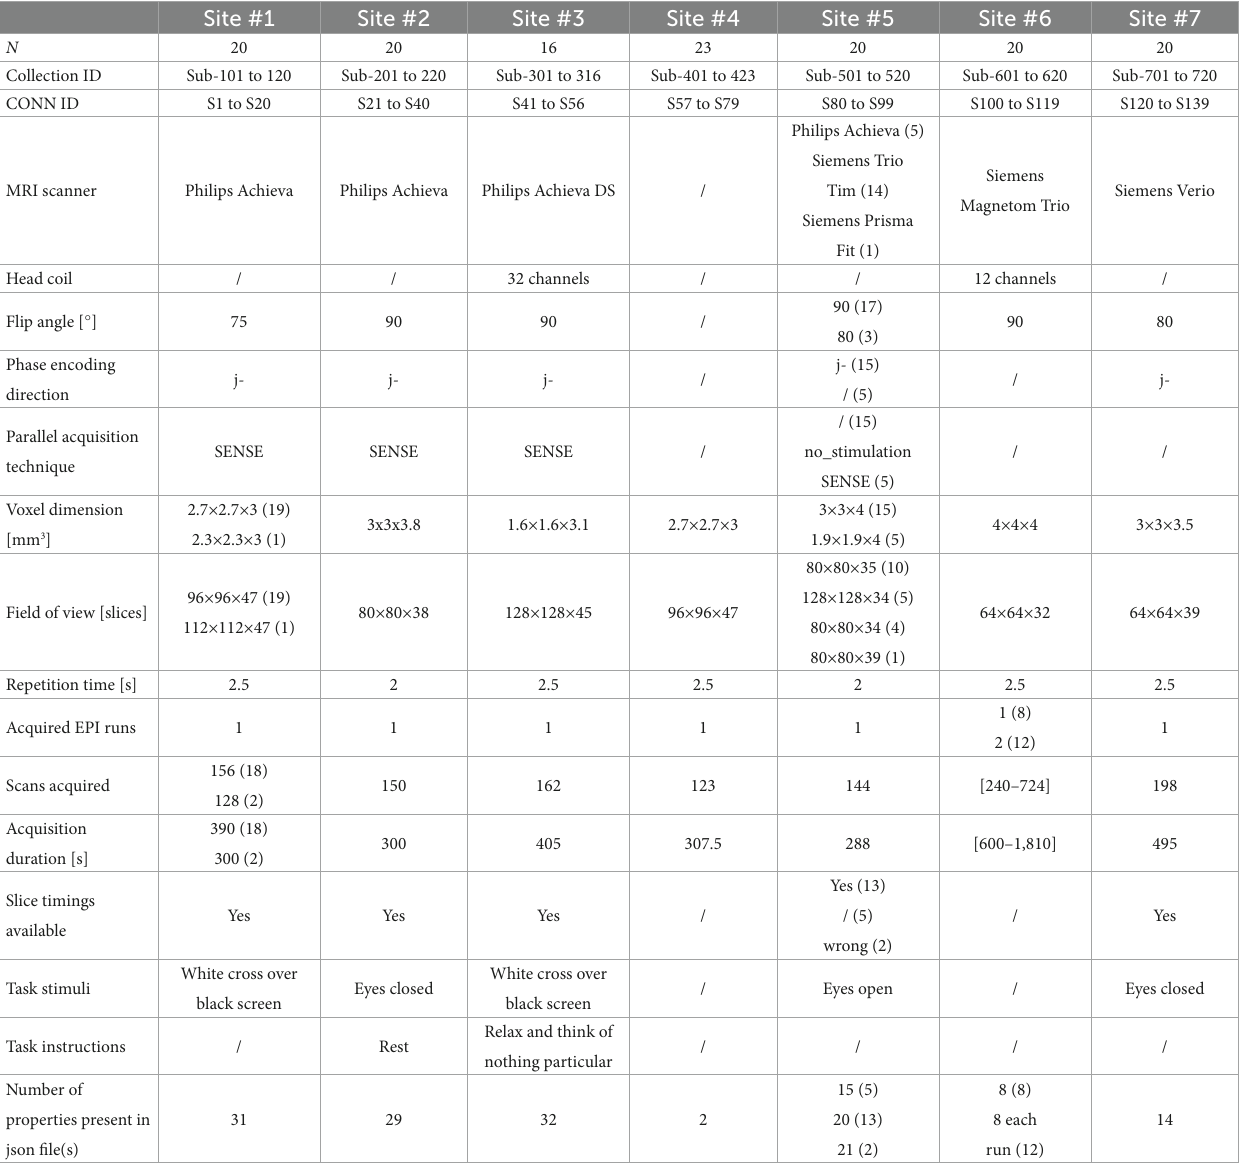
TABLE 2 Functional MRI data information for each acquisition